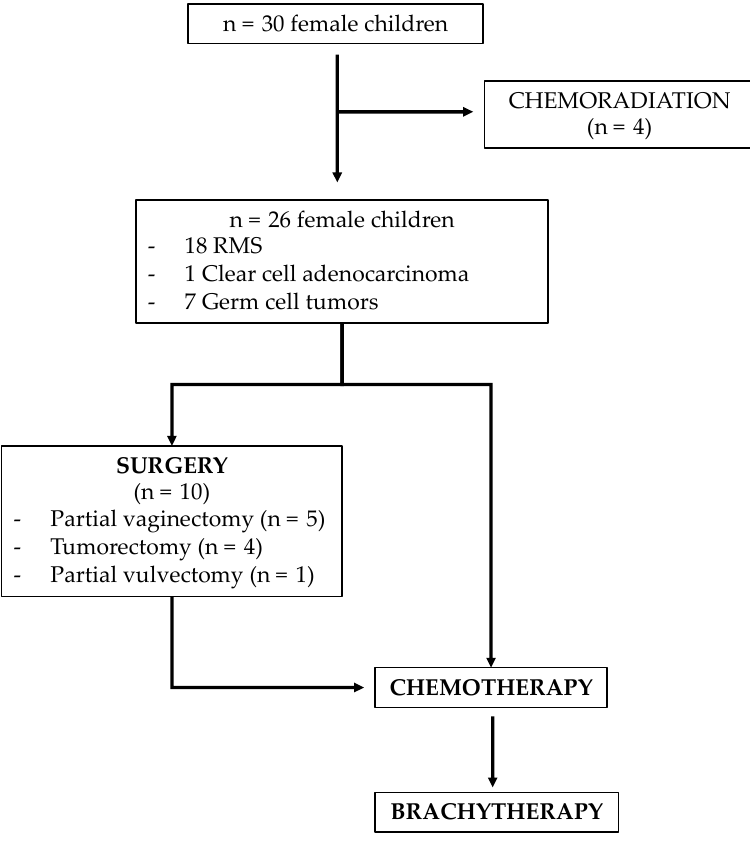
Figure 2. Selection process.